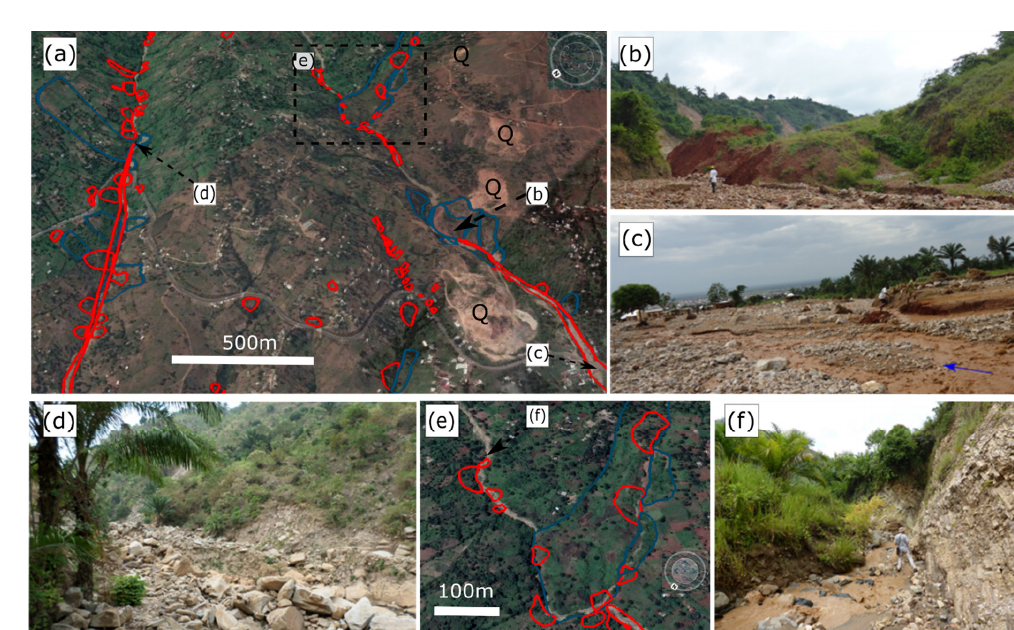
Figure 5. ( a ) ©Google Earth image (12 March 2021) of landslides triggered by an intense rainfall event in February 2014. Shallow and deep-seated landslides are in red and blue respectively. Note also the presence of quarries and mines (Q). ( b ) Toe of a landslide dam partly associated with quarrying and mining activities that blocked the river. Photo taken in July 2014. ( c ) Example of debris-rich flash flood impact in the Gasenyi River, resulting from the breaching of the upstream landslide dam. The photo was taken a few hours after the event at around 1.5 km downstream of the point indicated by the C arrow. ( d ) Debris flows with lateral sediment supply from debris avalanches. Photo taken in July 2014. ( e ) ©Google Earth image (7 March 2018) of an active earthflow in contact with the Gasenyi river. ( f ) Toe of the earthflow and sediment supply into the river system. Photo taken in July 2014. Table 3 provides example of impacts from landslides on infrastructure and people. The landslide and flash flood event of 9 February 2014 (see Section 4.1 for the description of the processes; Figure 5) was one of the most destructive events in the region during the last decade. Another example of the destructive impact of landslides was observed on the national road NR 7 (Figure 6). The original road, built between 1980 and 1984, ran parallel with the northern side of the Kanyosha river. However, this design ignored the presence of numerous landslides, notably the presence of two active large earthflows. Due to the constant damage inflicted to the road, the authorities had no option but to abandon a sec- tion with a length of roughly three kilometers. Overall, the large earthflows in the region are frequently associated with pervasive damages, which explains why they are usually less inhabited compared to their surroundings. Pervasive damages are also observed along the gully systems in the Rift sediments (Figure 7) and along some river reaches. The